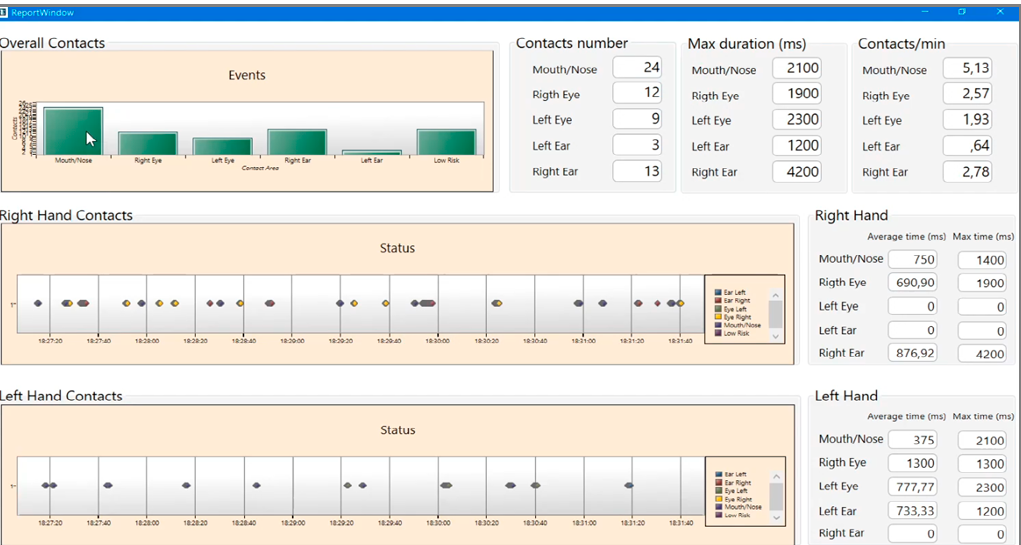
Figure A1. The HealthSHIELD tool’s main window for the real-time monitoring modality. In the display area, a worker at a seated workstation.